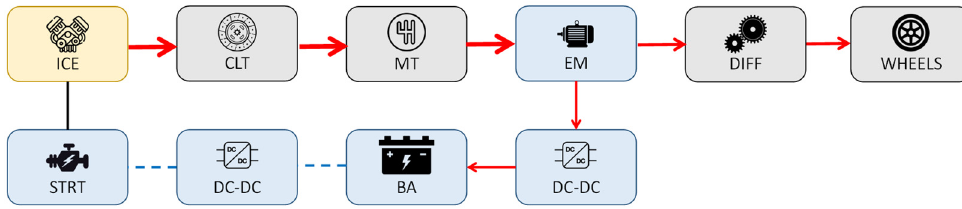
Figure 9. Energy fluxes in traction-charging mode.